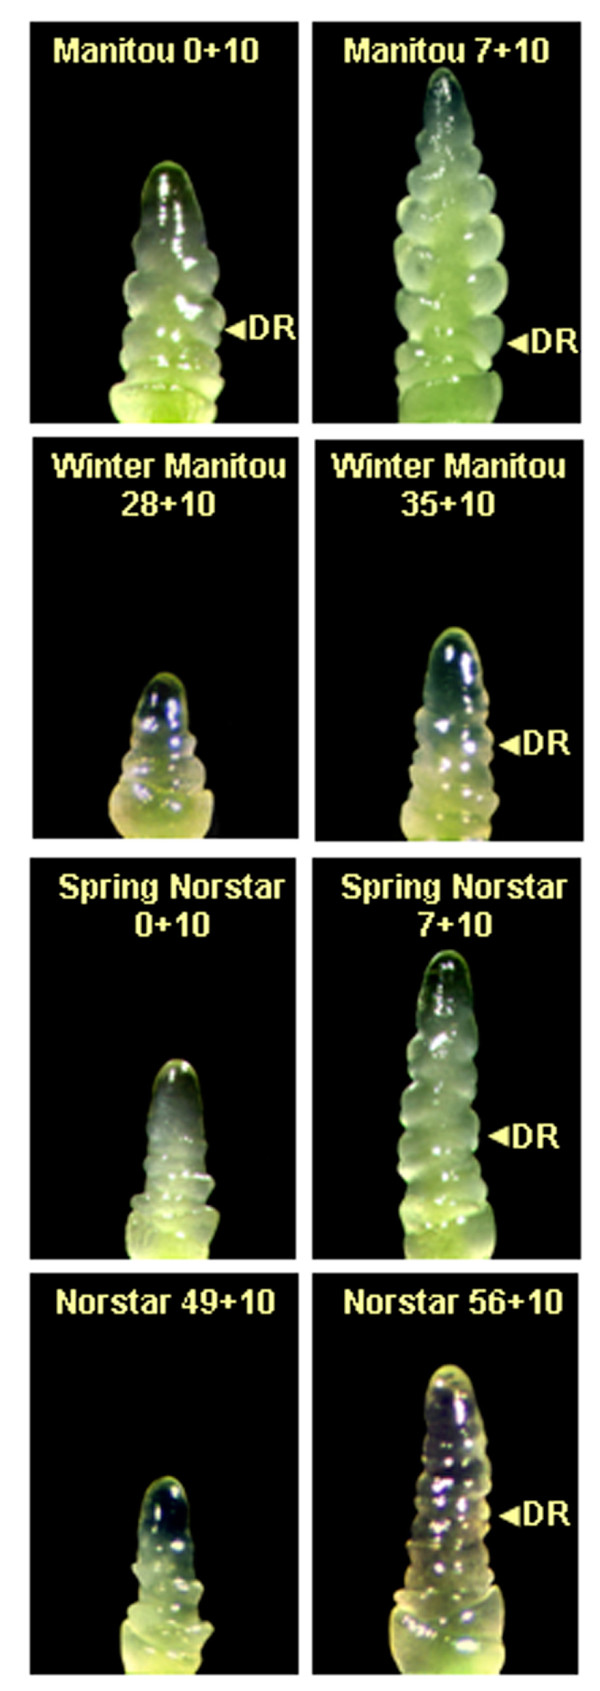
Shoot apex development in winter Norstar and spring Manitou and the near isogenic lines spring Norstar and winter Manitou. Day 0 is the start of vernalization/acclimation at 6°C following 2 d growth at 4°C plus 13 d at 20 to 22°C (15 day pre-treatment). First number in each plate indicates the days the plants were grown at 6°C. Second number (10) indicates that the plants were grown an additional 10 days at 20°C before sampling for dissection e.g., 7 + 10 indicates 7 d at 6°C followed by 10 d at 20°C. Arrow indicates double ridge. The apices of samples that bracket the vegetative to reproductive phase transition for each genotype are shown. A) Manitou 0+10 SAM at stage-5; B) Manitou 7+10 SAM at stage-7; C) Winter Manitou 28+10 SAM at stage 0; D) Winter Manitou 35+10 SAM at early stage-5; E) Spring Norstar 0+10 SAM at stage-2 F) Spring Norstar 7+10 SAM at stage-5; G) Winter Norstar 49+10 SAM at stage-2 H) Winter Norstar 56+10 SAM at stage-5. DR, double ridge, was used as a marker of a reproductive meristem.